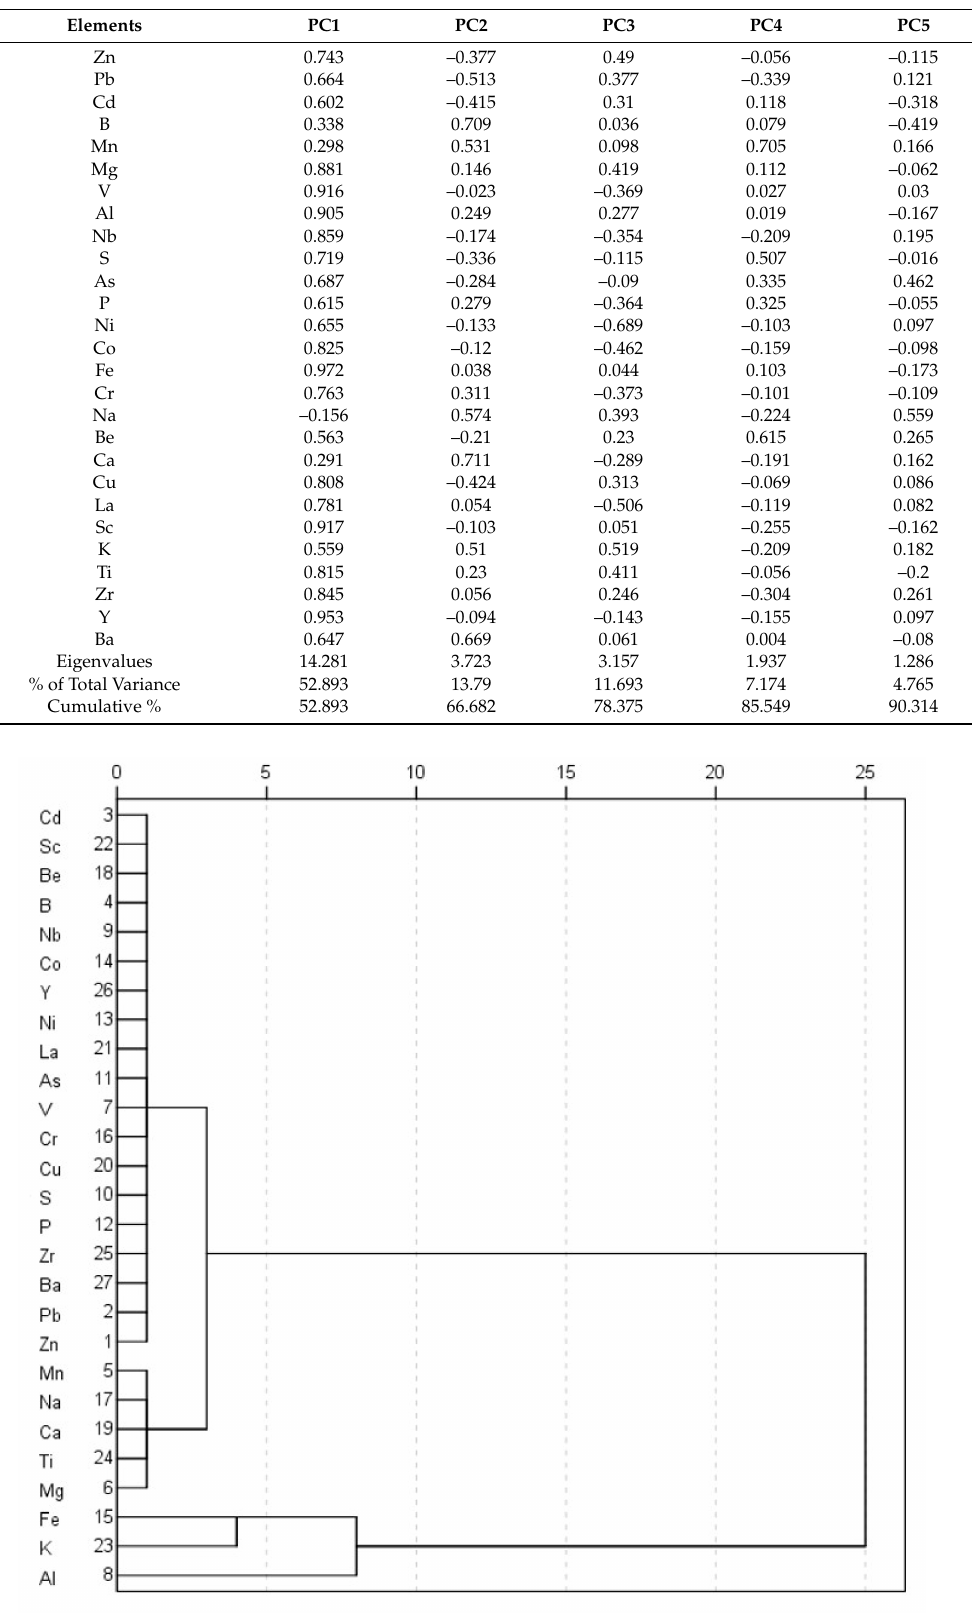
Figure 5. Clustering analyses of elements at all